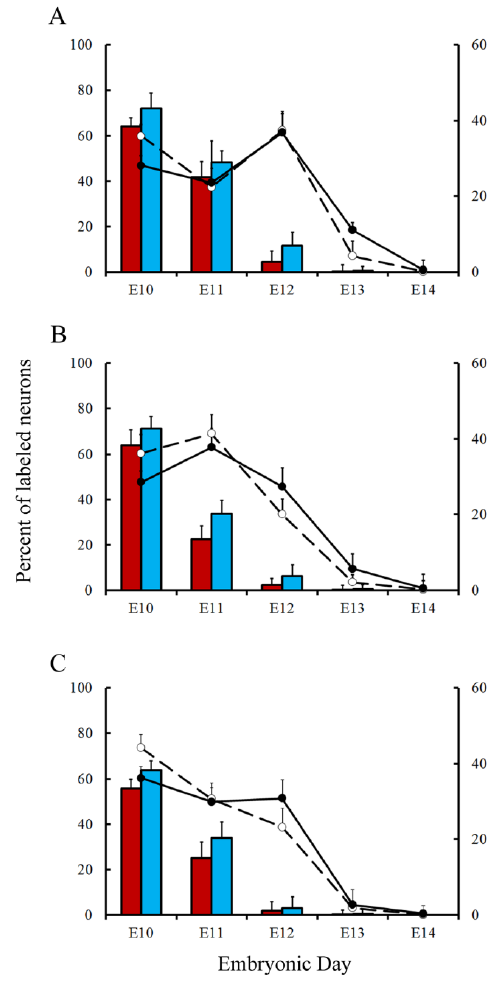
Figure 7. Comparison of deep nuclei neurons neurogenetic patterns in animals injected with bromodeoxyuridine (red columns) or [ 3 H]TdR (blue columns) at the level of the fastigial ( A ), interpositus ( B ), and dentate ( C ) nuclei. Developmental timetables of deep nuclei neurons were inferred using bromodeoxyuridine (open circles and dashed lines) or [ 3 H]TdR (closed circles and solid black lines). E: embryonic day. Values are expressed as mean ± SEM.